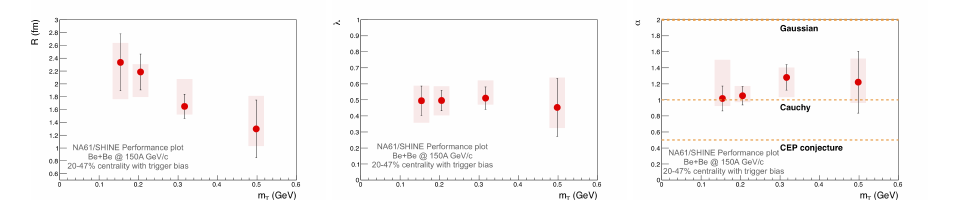
Figure 6. Performance analysis of Bose-Einstein correlations in semi-central Be + Be interactions at 150 A GeV / c. The HBT radius (left), λ (middle) and α parameters dependence on transverse mass.